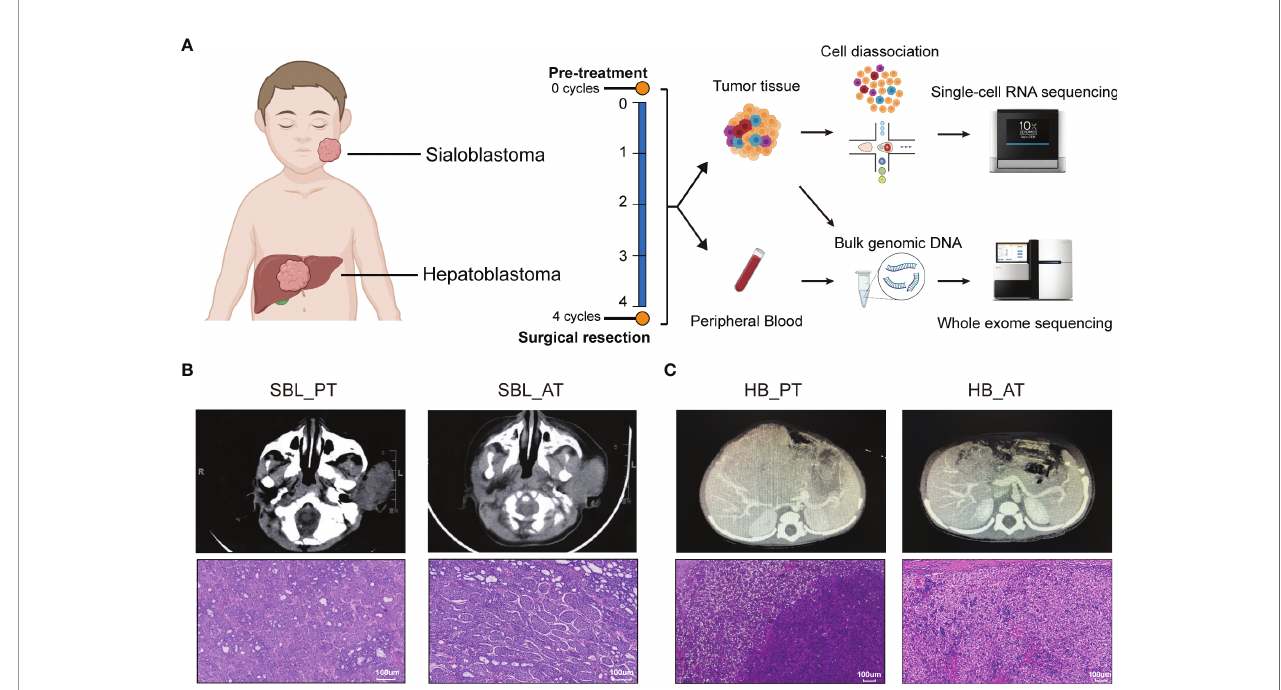
FIGURE 1 | The occurrence of two synchronous pediatric tumors. (A) Diagrams of the study design and sample work fl ow (Created with BioRender.com). Fresh tumor specimens were collected at the timepoint of surgical biopsy and tumor resection. (B) CT images and H&E staining of SBL before and after neoadjuvant chemotherapy. (C) CT images and H&E staining of HB before and after neoadjuvant chemotherapy. CT, Computed tomography; H&E, hematoxylin and eosin; SBL, sialoblastoma; HB, hepatoblastoma; PT, primary tumor; AT, tumor after